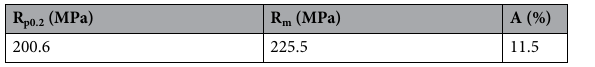
Table 2. Tensile properties of the EN AW 6060 T66 aluminous alloy.